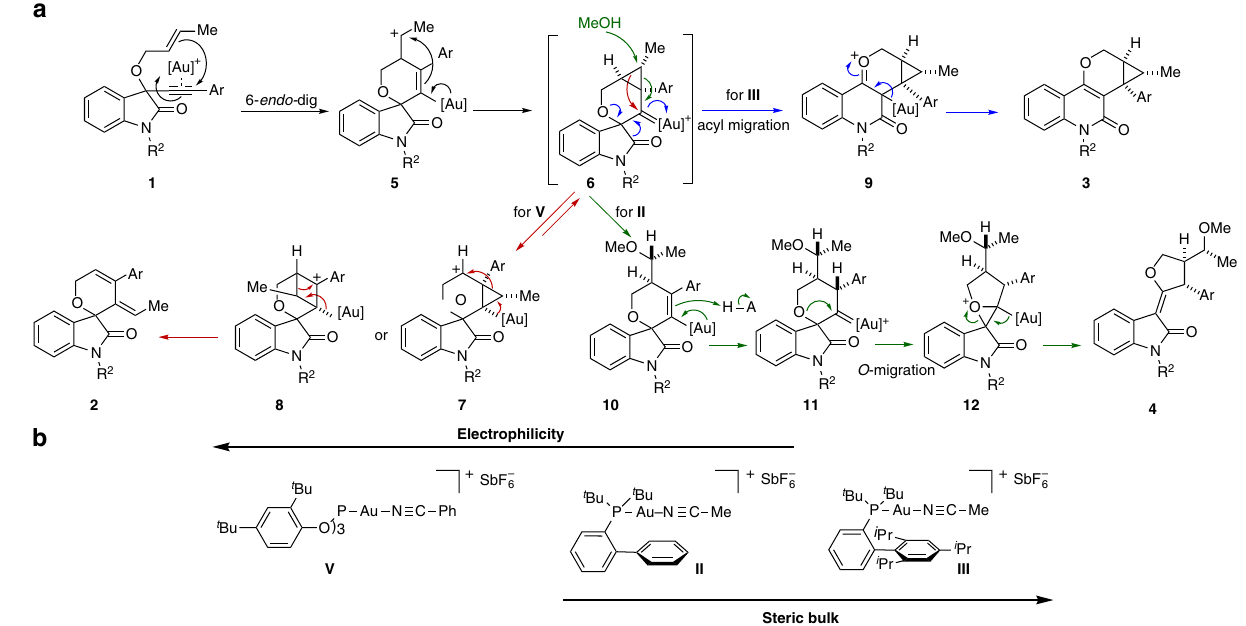
Figure 3 | Proposed mechanistic pathways of divergent gold(I) catalysis to afford different scaffolds. ( a ) The spirooxindole gold carbene intermediate 6 was formed by the cationic gold(I) activation of alkyne 1 , followed by 6- endo- dig cyclization and cyclopropane formation. The most electrophilic gold(I) catalyst V induces a sequential cyclopropane migration and deauration to generate spirooxindole 2 (magenta arrows). Very bulky gold complex III promotes the pinacol type acyl migration followed by deauration to afford quinolone 3 (blue arrows). In the presence of MeOH, the less bulky but relatively more electrophilic gold complex II allows the 1,4-nucleophilic addition of methanol to open up the cyclopropane ring ( 10 ). Subsequent protonation, spiroether insertion and deauration in 10 generate the df- oxindole 4 (turquoise arrows). ( b ) A comparison of the molecular properties of the cationic gold catalysts II , III and V